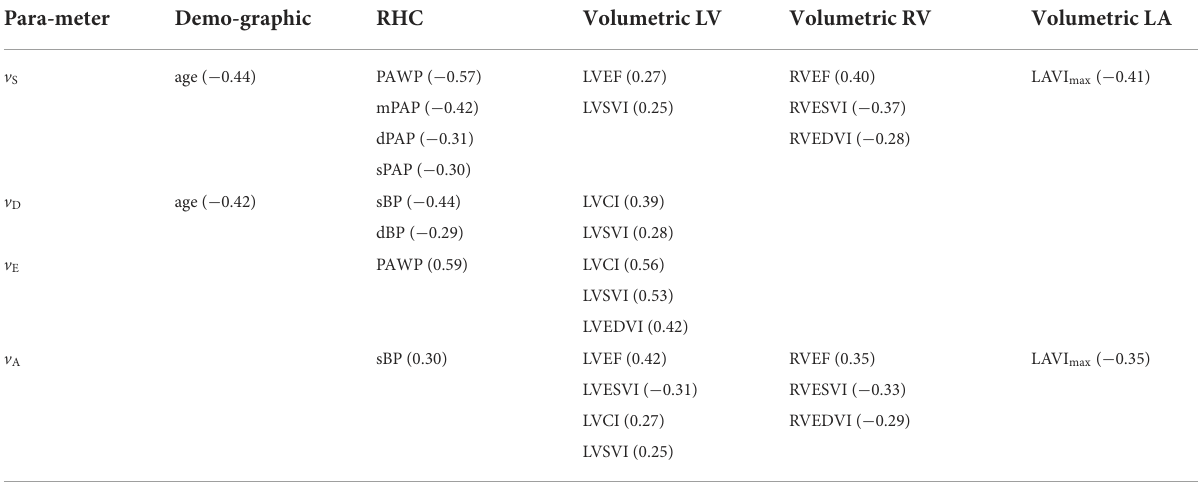
TABLE 3 Significant correlations of LA peak in- and outflow velocities with demographic, RHC-derived hemodynamic and MR-derived volumetric cardiac parameters. Para-meter Demo-graphic RHC Volumetric LV Volumetric RV Volumetric